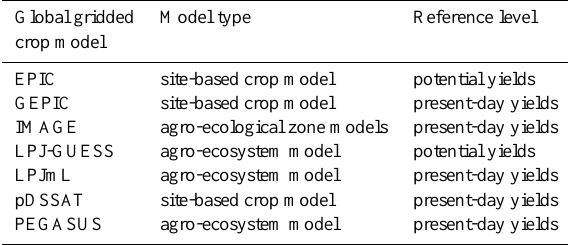
Table 1. Short characterisation of the applied global gridded crop models. More details are provided in Table S1 in the Supplement.